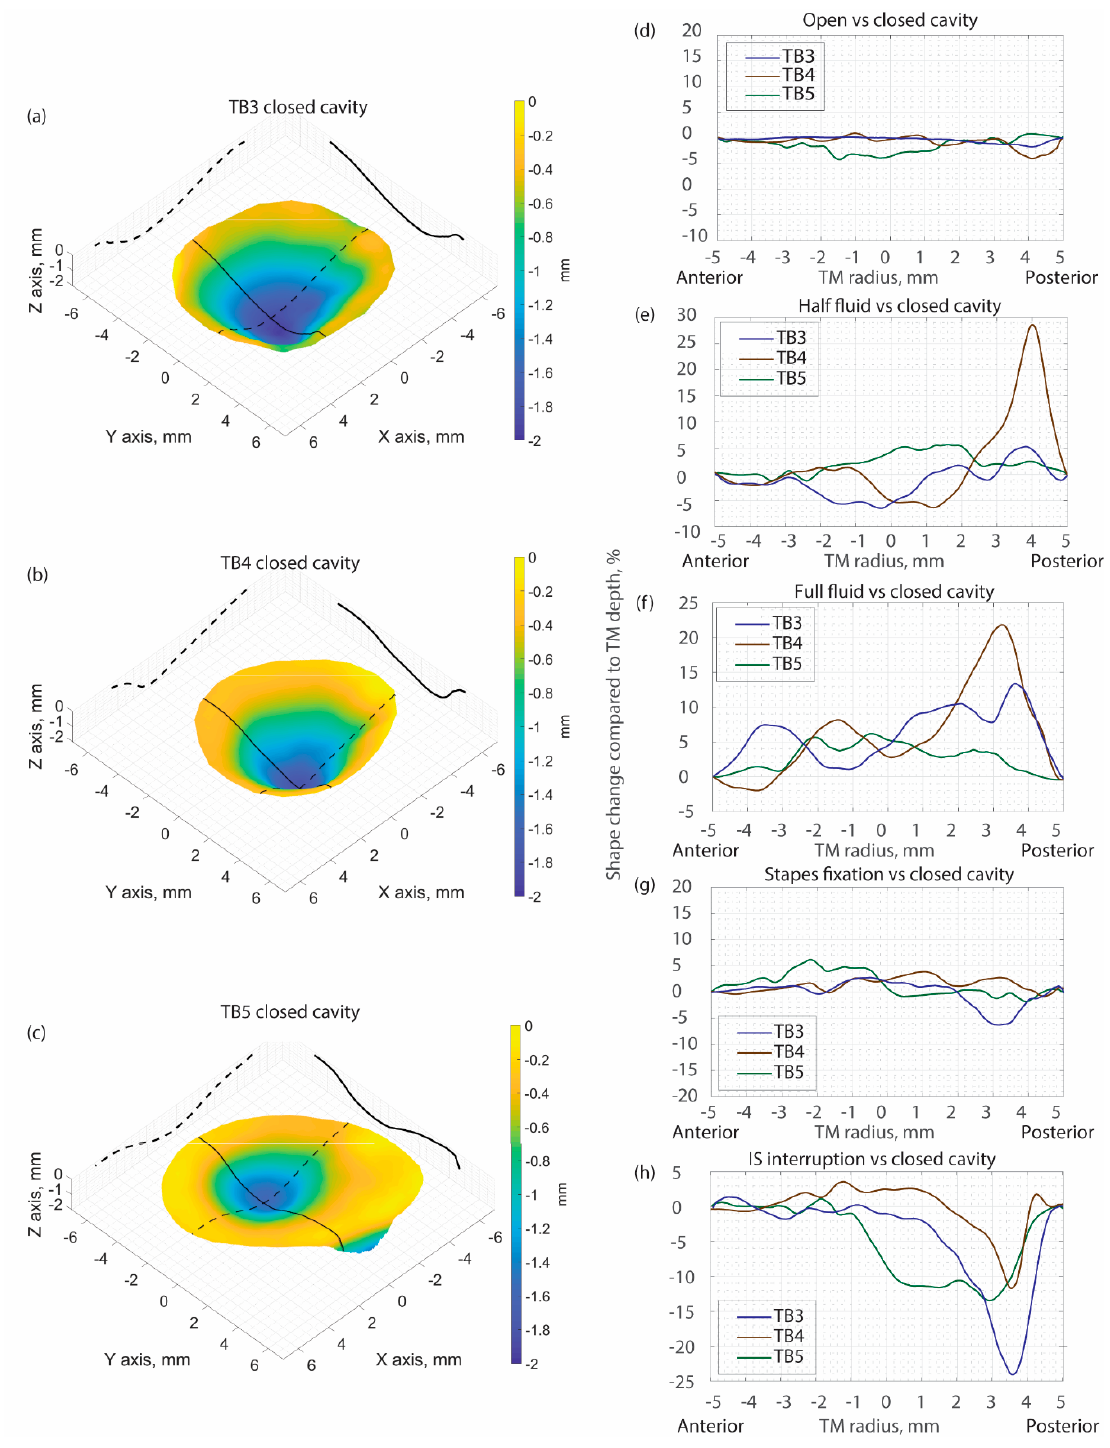
Figure 3. ( a ):TB3 shape when the middle-ear cavity is closed; ( b ):TB4 shape when the middle-ear cavity is closed;( c ): TB5 shape when the middle-ear cavity is closed; Comparison of TM shape along the black solid line marked in the left panel in TB 3~5 ( d ): between open and closed cavity condition; ( e ): between half fluid injection and closed cavity condition; ( f ): between full fluid injection and closed cavity condition; ( g ): between Stapes fixation and closed cavity condition; ( h ): between IS joint interruption and closed cavity condition.3.2. Representative Displacement Measurement Results